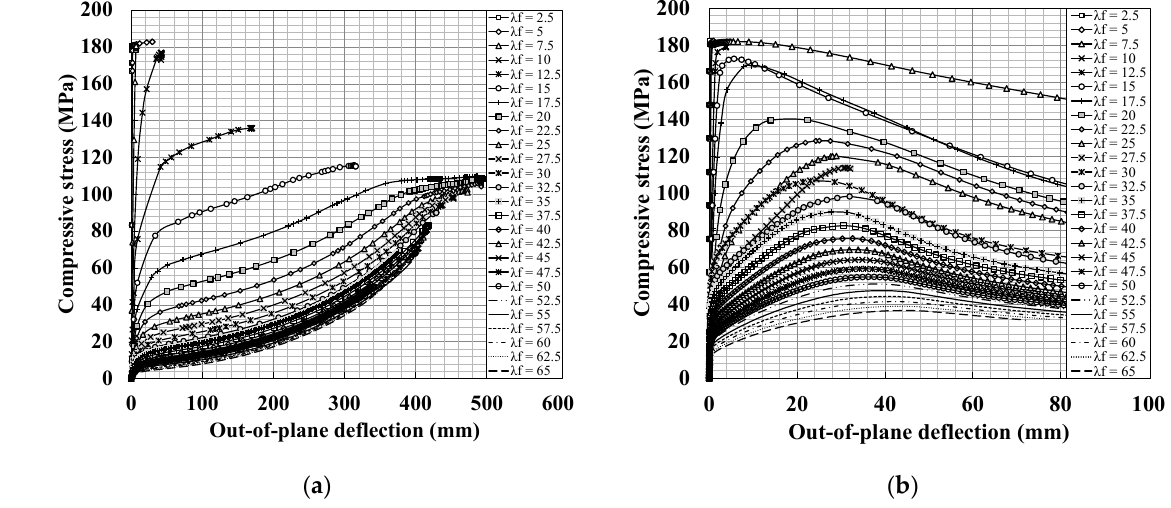
Figure 13. Relationship between compressive stress and out-of-plane deflection for the steel flanges modeled using the elastic-perfectly plastic model according to slenderness ratio ( 𝜆 (cid:3033) ): ( a ) hinge support condition and ( b ) fixed support condition .